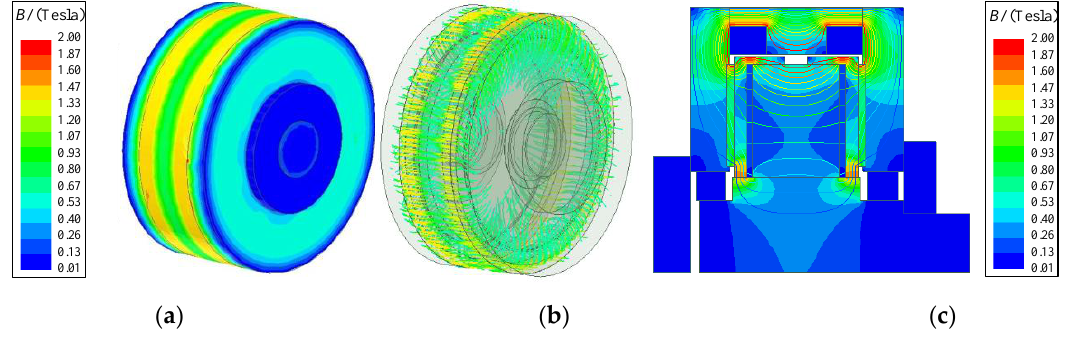
Figure 8. Cloud chart of magnetic induction intensity and magnetic lines of force at the current of 3.0A. ( a ) 3D cloud chart, ( b ) streamline of the magnetic induction intensity, and ( c ) magnetic field distribution on an arbitrary cross-section.